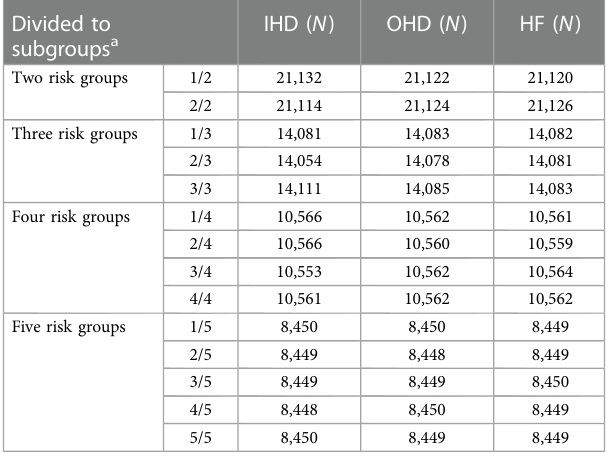
TABLE 3 Hazard-based risk-group strati fi cation.